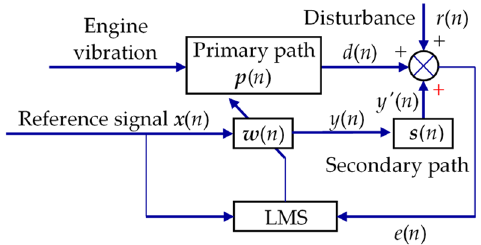
Figure 3. LMS adaptive feedforward control block diagram.